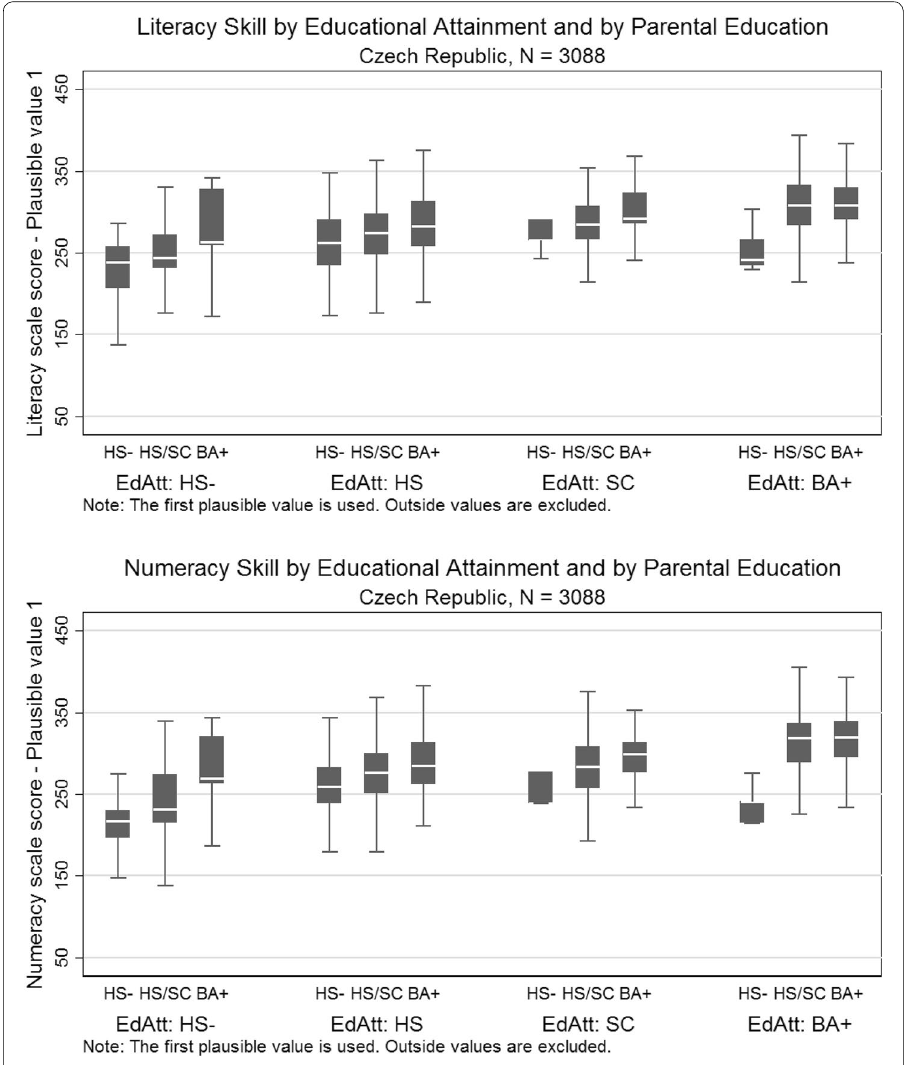
Fig. 2 Boxplots of Distributions of Literacy and Numeracy by Education Attainment and Parental